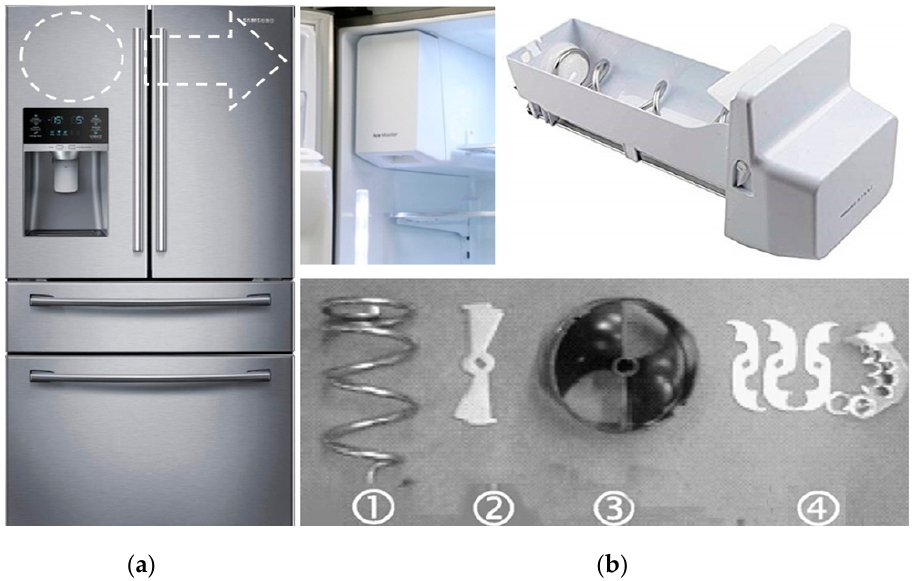
Figure 4. Refrigerator and ice-maker assembly. ( a ) Refrigerator; ( b ) mechanical parts of an ice-maker